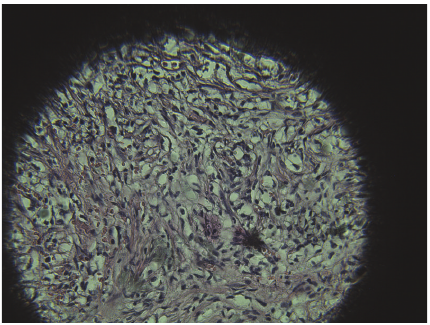
Figure 2: There are xanthomatous cells separated from fibrotic septae in a fibrotic stroma, without atypia and no cellular pleomor-